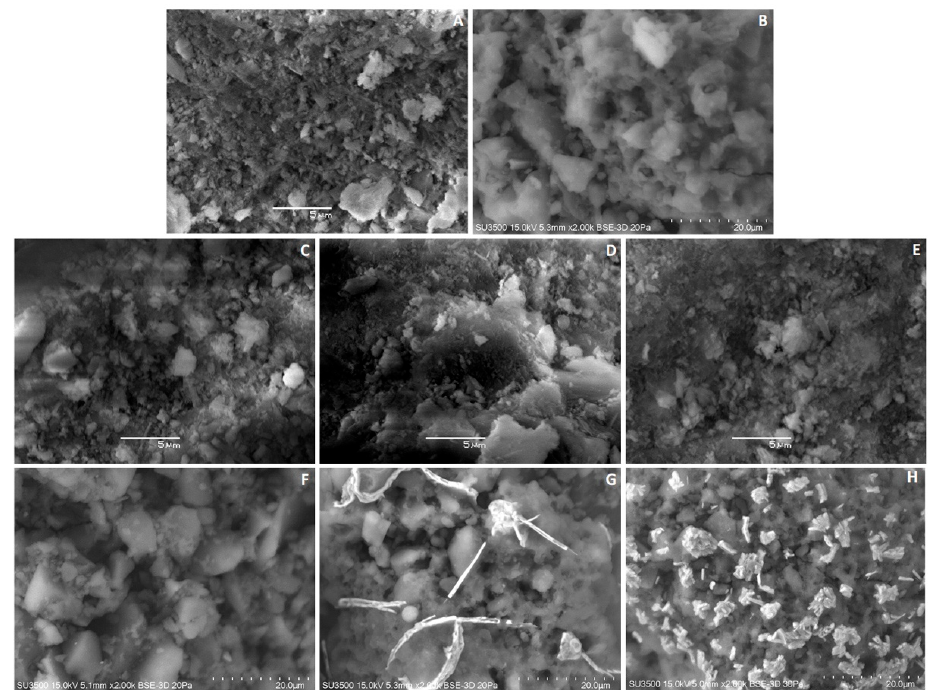
Figure 2. Scanning electron microscopy images of parent zeolite support and prepared single and double metal oxide catalysts supported on modified natural zeolite: ( A ) ZNAT; ( B ) FS; ( C ) ZH_Cu; ( D ) ZH_Zn; ( E ) ZH_Zn/Cu; ( F ) FS_Cu; ( G ) FS_Zn; ( H ) FS_Zn/Cu.